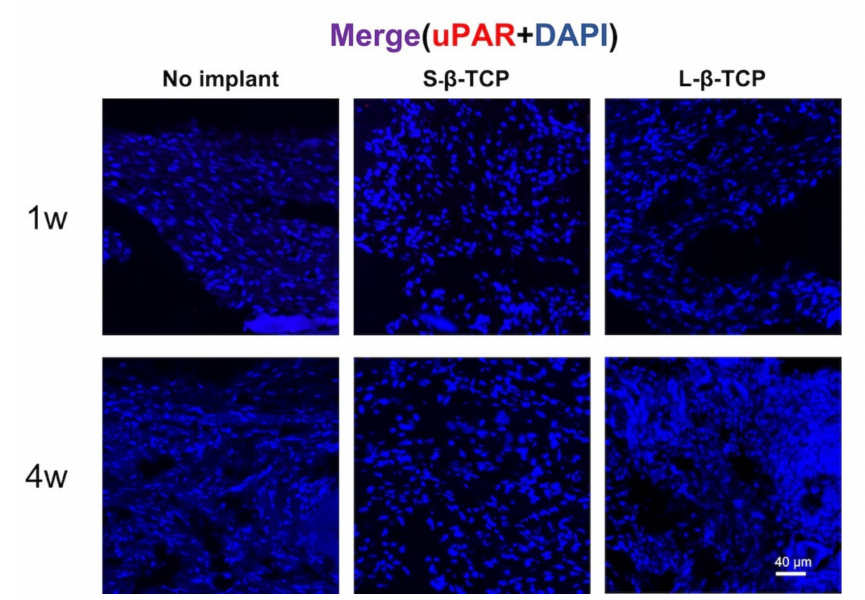
Figure 5. Identification of cellular senescence in bone defects. Immunofluorescent staining images of bone defects at one week and four weeks after operation stained with urokinase plasminogen activator receptor (uPAR) antibody and DAPI (scale bar = 40 µ